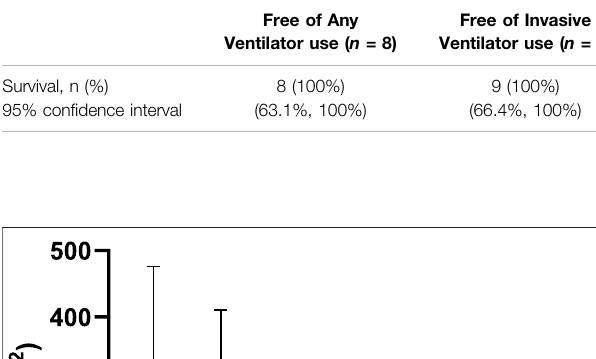
Frontiers in Pharmacology |